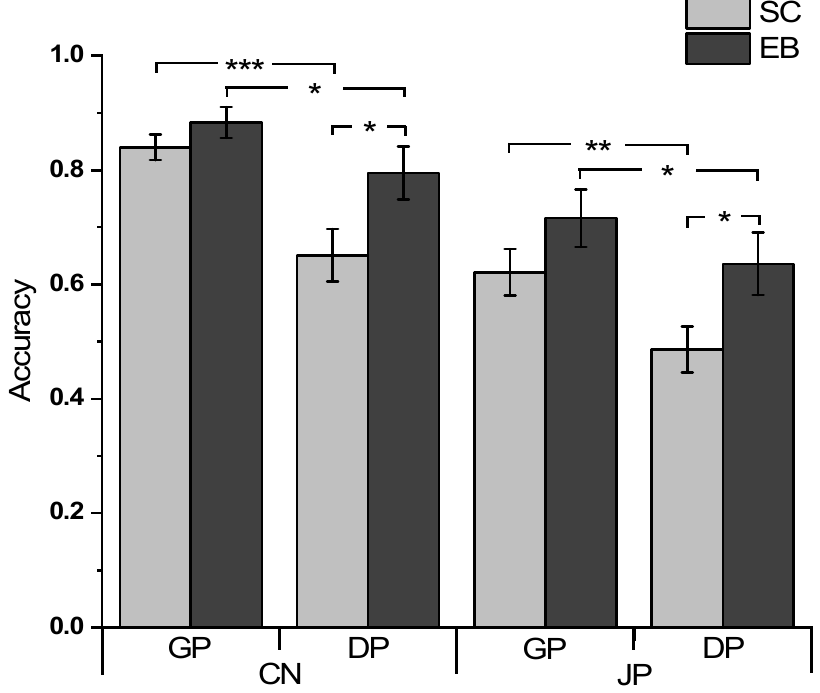
Figure 2. Mean voice-recognition performance of the sighted and early blind participants in each condition. Abbreviations: CN, Chinese condition; JP, Japanese condition; GP, Generalization phase; DP, Delayed memory phase; SC, Sighted control; EB, Early blind. Significance indicated by * ( p < 0.05), ** ( p < 0.01), and *** ( p < 0.001). Error bars represent the standard error of the mean.